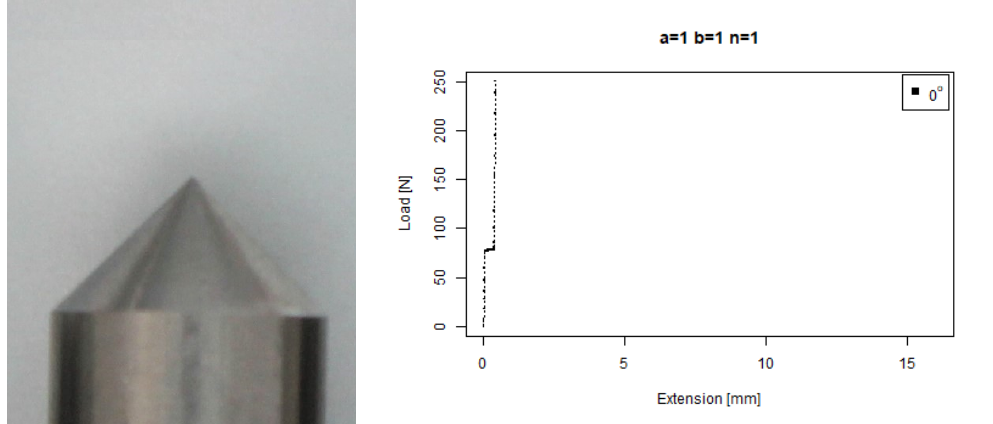
Figure 5. Angled tip with a = 1, b = 1, n = 1. ( Left ) Tip Profile. ( Right ) Experimental